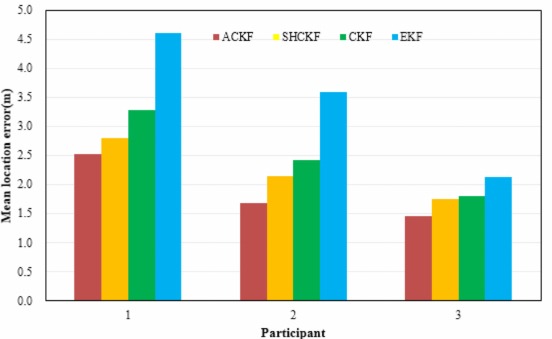
Figure 11. Distributions of the mean of location errors in location tracking for three